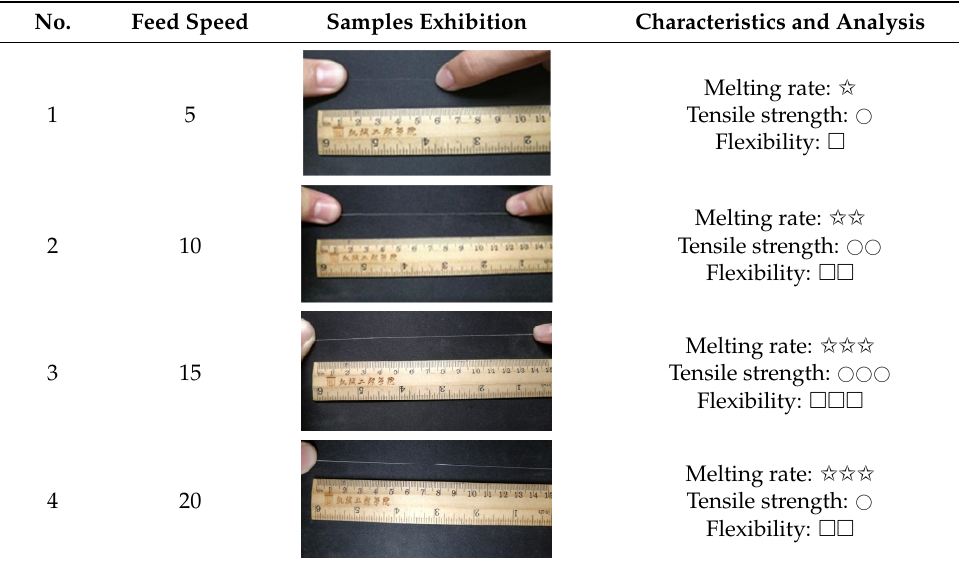
screw was 15 mm/min. Table 3. Performance effects of different feed speeds of screws on ceramic fiber at melting temper ‐ Table 3. Performance effects of different feed speeds of screws on ceramic fiber at melting temper ‐ Table 3. Performance effects of different feed speeds of screws on ceramic fiber at melting temper ‐ Table 3. Performance effects of different feed speeds of screws on ceramic fiber at melting temper ‐ ature of 220 °C, TPU ‐ 95A# and nozzle diameter of 0.3 mm. Table 3. ature of 220 °C, TPU ‐ 95A# and nozzle diameter of 0.3 mm. ature of 220 °C, TPU ‐ 95A# and nozzle diameter of 0.3 mm. Performance effects of different feed speeds of screws on ceramic fiber at melting temperature ature of 220 °C, TPU ‐ 95A# and nozzle diameter of 0.3 mm. Table 3. Performance effects of different feed speeds of screws on ceramic fiber at melting temper ‐ Table 3. Performance effects of different feed speeds of screws on ceramic fiber at melting temper ‐ of 220 ◦ C, TPU-95A# and nozzle diameter of 0.3 mm. ature of 220 °C, TPU ‐ 95A# and nozzle diameter of 0.3 ature of 220 °C, TPU ‐ 95A# and nozzle diameter of 0.3 mm.